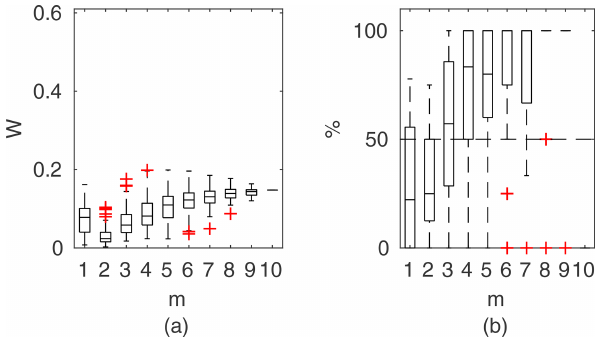
Figure B11. Manning DCM results for the Ritobacken case study, spring 2011: (a) averaged relative confidence widths W as a func- tion of observation set size m used for model identification; (b) percentage of verification points enclosed by the confidence inter- vals (100% denotes all points within intervals, box spans over the 25% and 75% quantiles, the median is given with horizontal line, whiskers indicate the result extent, and cross marks are for extreme values).